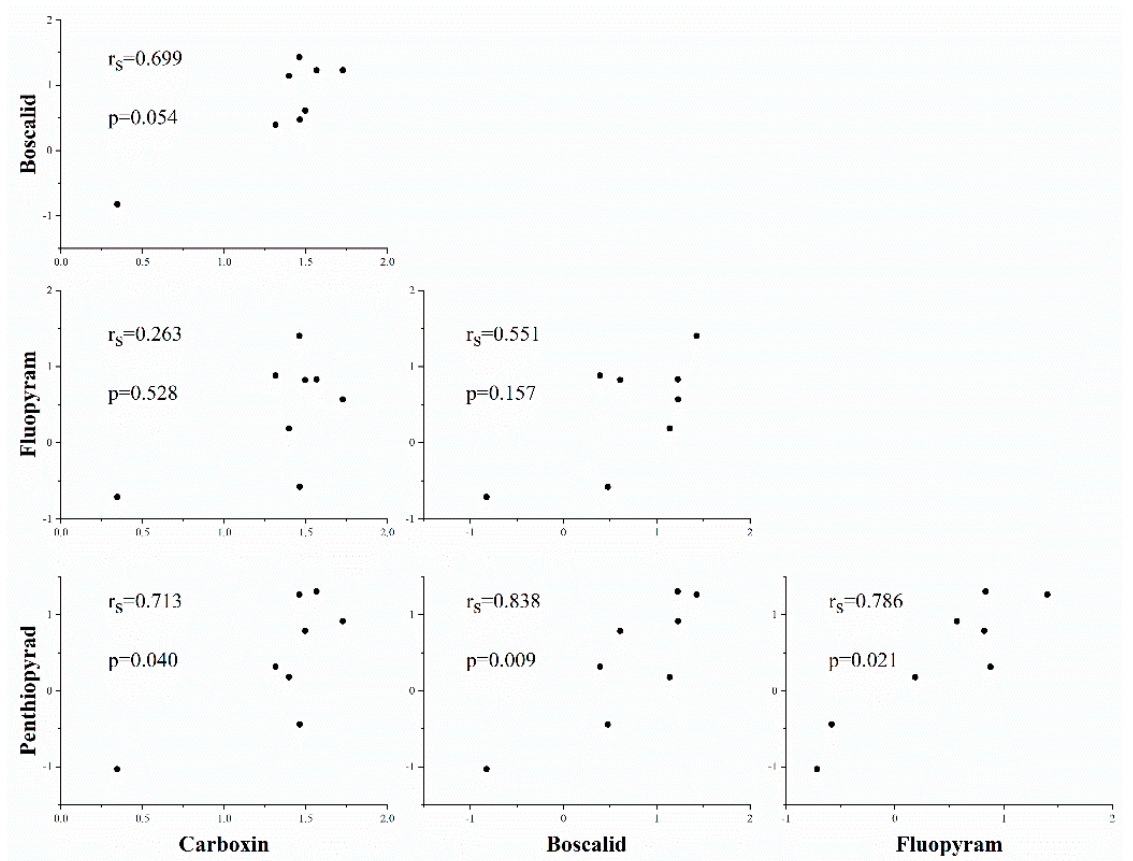
Figure 3. Spearman’s correlations between the resistance to three SDHI for C. cassiicola strains with various double mutations. Sensitivity data measured as EC 50 ( µ g/mL) values are expressed on a log 10 scale. p < 0.05 indicates that the correlation was statistically significant.